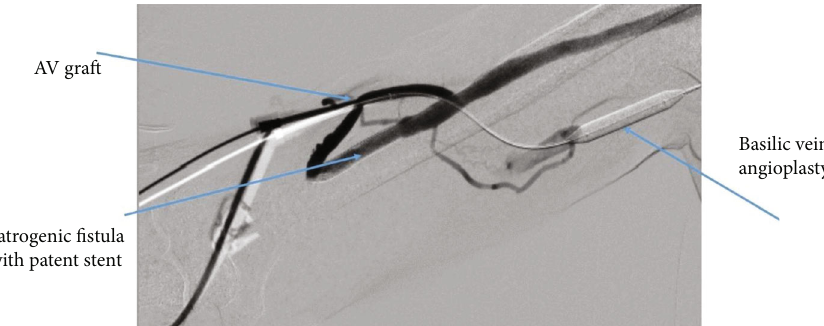
Figure 7: Patent graft to cephalic vein stent and basilic vein angioplasty.